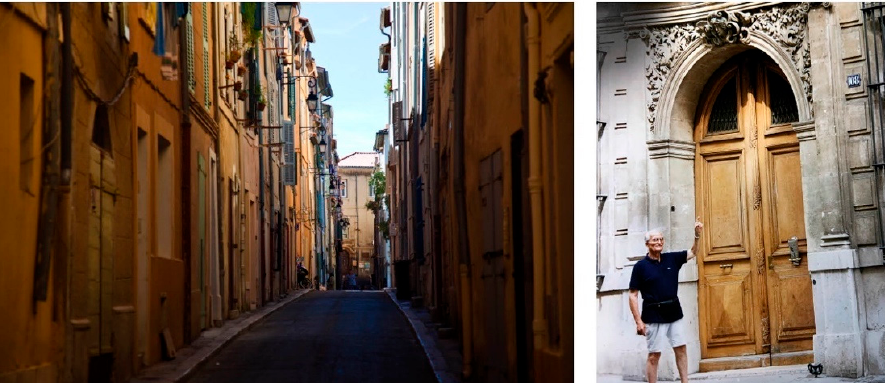
Figure 6. ( Left ) The medieval streets of Le Panier in Marseille in 2010. Photograph by phgaillard2001, CC BY-SA 2.0 via Wikimedia Commons. ( Right ) Henri Régis, the author’s uncle, in front of their cousins’ home on Rue Sylvabelle. Photograph by Helen A. Regis.